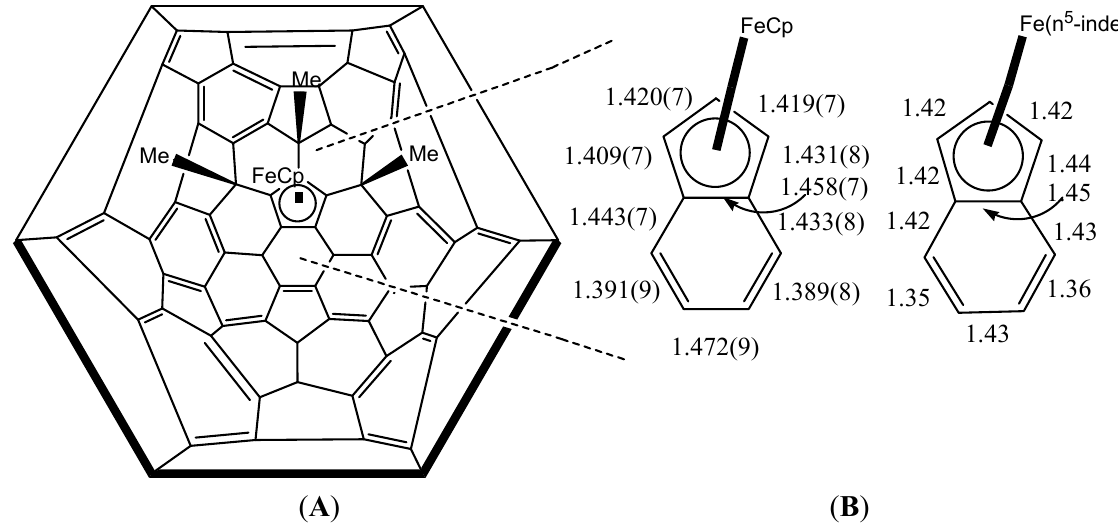
Figure 12. Indenyl iron(II) structure identified in ferrocene/C compared to that from Fe( η 5 -indenyl) (Reproduced from [47] with